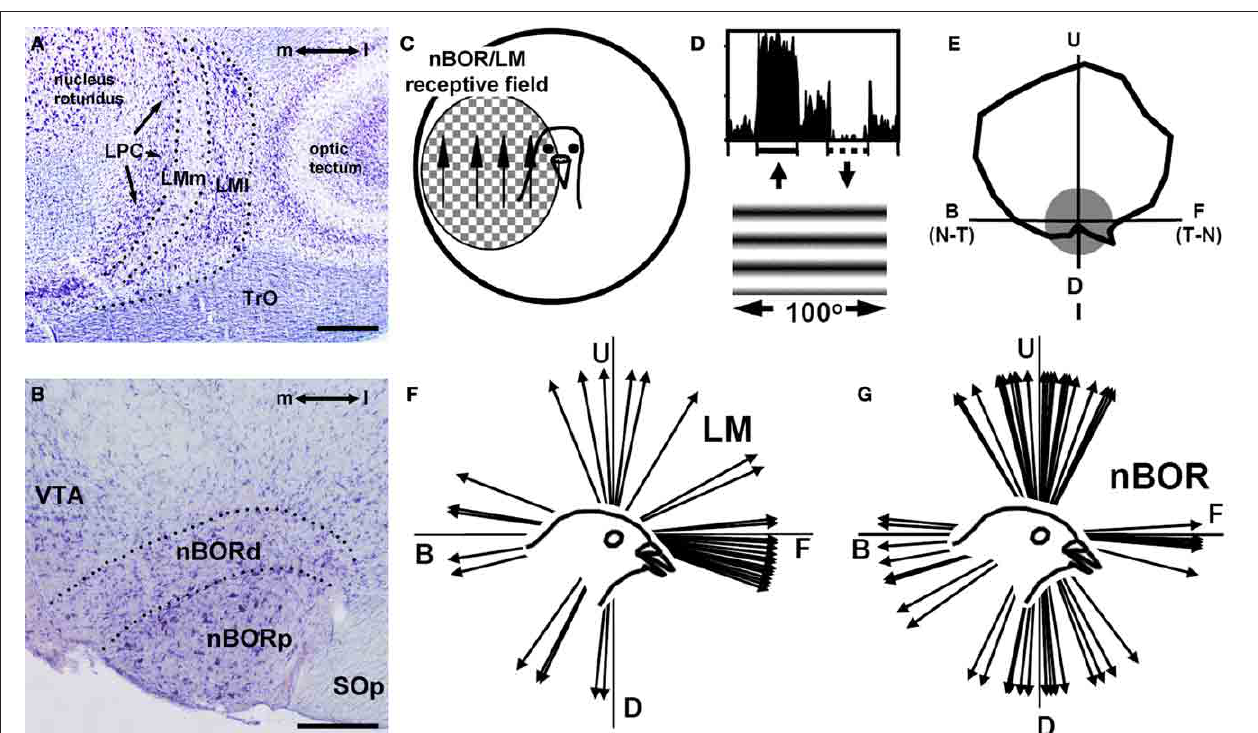
FIGURE 2 | Basic visual processing in the accessory optic system in birds. (A) and (B) , Respectively, show Nissl-stained coronal sections through the pigeon lentiformis mesenceophali (LM) and nucleus of the basal optic root (nBOR). (C) Indicates that most nBOR and LM neurons have large receptive fields in the contralateral visual field and exhibit directional tuning in response to largefield motion (e.g., Burns and Wallman, 1981; Winterson and Brauth, 1985). (D) Shows the response of a nBOR neuron to upward (excitation) and downward (inhibition) motion of a large drifting sine-wave grating (from Crowder and Wylie, 2001). (E) Shows a directional tuning curve